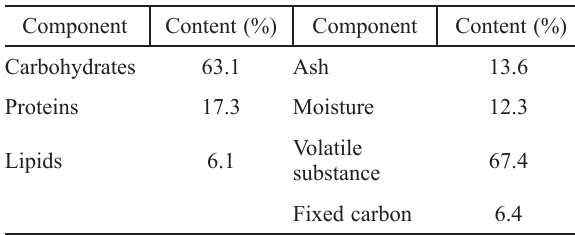
Table 1 – Chemical composition and proximate analysis of U. lactuca Component Content